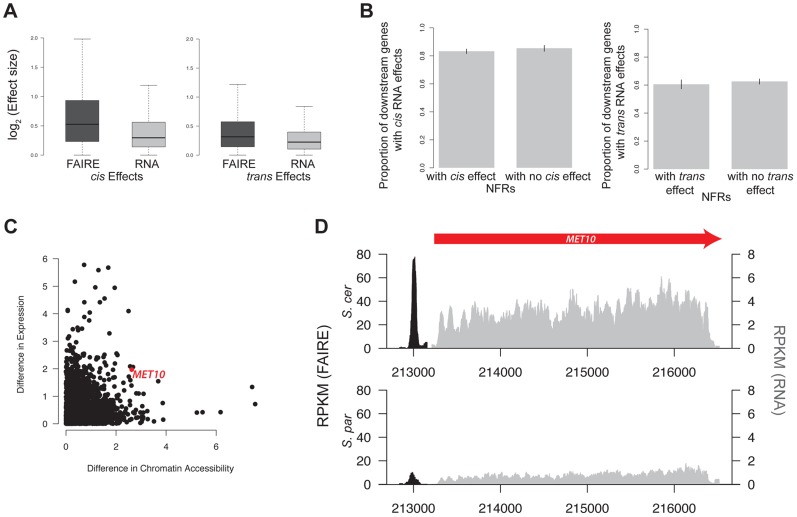
Gene expression and chromatin accessibility.A. Boxplot of log2(effect size) of both cis and trans effects for FAIRE (dark grey) and RNA (light grey). B. Barplot of the percentage of genes with significant cis effects in RNA that are downstream of NFRs with and without cis effects (left). Barplot of the percentage of genes with significant trans effects in RNA that are downstream of NFRs with and without trans effects (right). C. Scatterplot of the log2(absolute value of the difference in chromatin accessibility between the two species) vs log2(absolute value of the difference in expression between the two species. The red dot indicates data from the MET10 gene, whose FAIRE-Seq and RNA data are shown in panel D. For clarity, the FAIRE-Seq data is only shown in a 100 bp window on either side of the NFR. FAIRE signal is shown in black, and RNA signal is shown in grey.